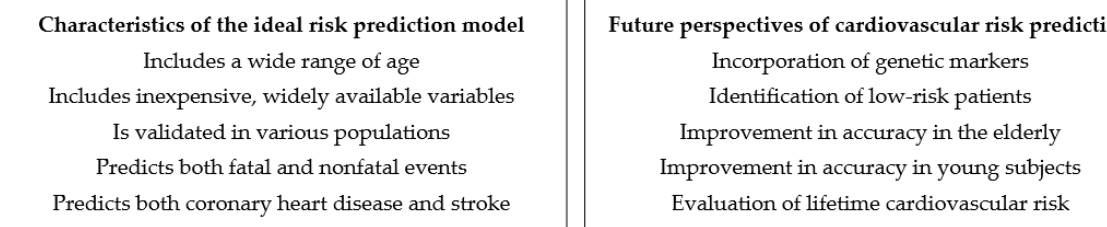
Figure 2. Key aspects of cardiovascular risk prediction.